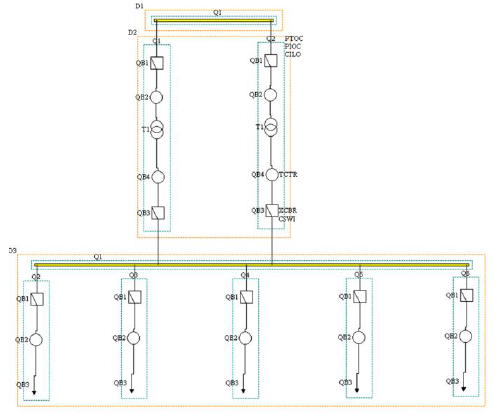
Figure 6. Single Line Diagram of the distribution network with functional requirements as logical nodes.